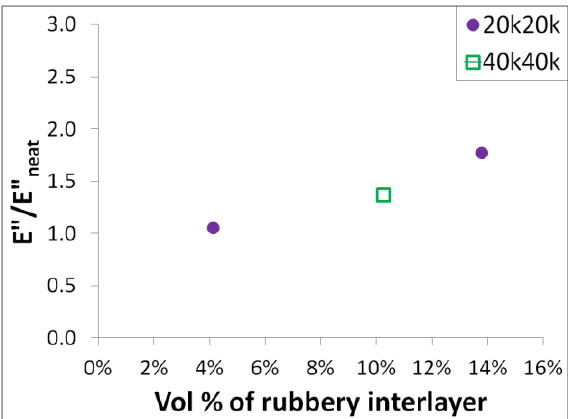
Figure 8. The rubbery interlayer volume fraction vs. the ratio of loss modulus of the nanocomposites and that of the neat epoxy at 0